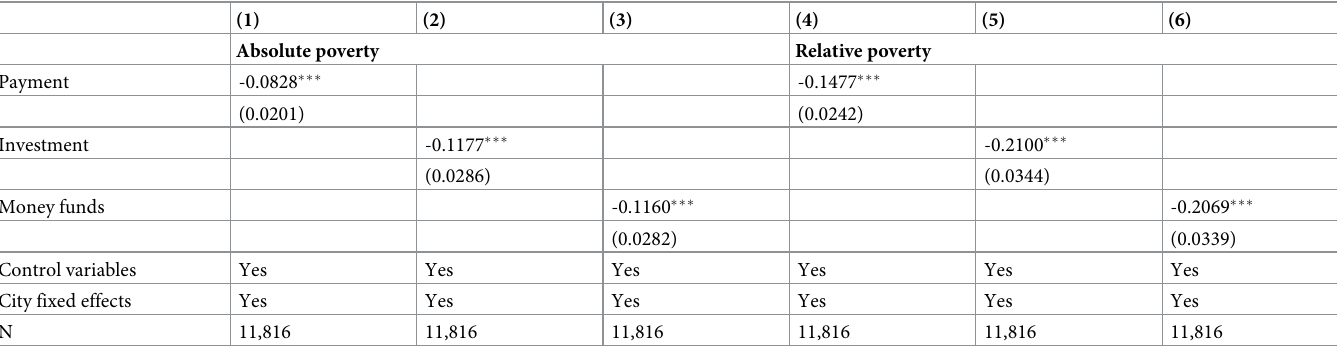
Table 13. Heterogeneity effects by digital financial usage depth.